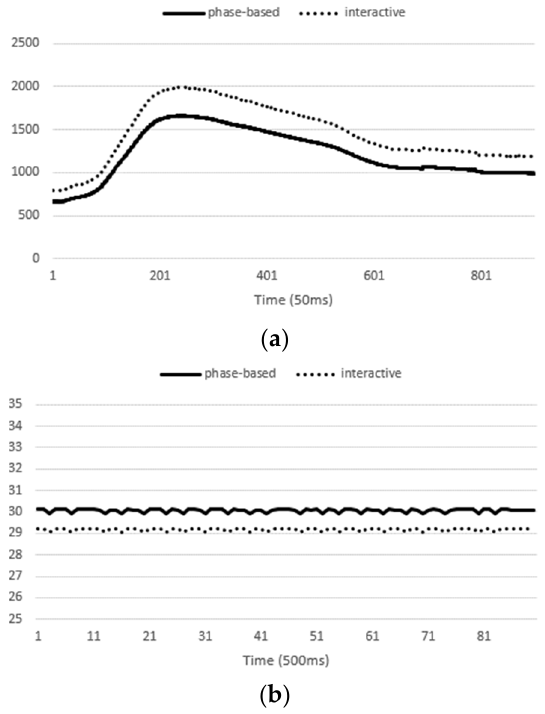
Figure 1. Comparisons of ( a ) power consumption and ( b ) FPS for the original interactive governor and phase-based interactive governor.